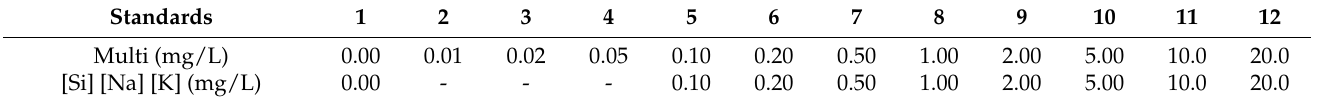
Table A3. The concentrations of the standard solutions used for cement chemical analyses by ICP–OES Standards